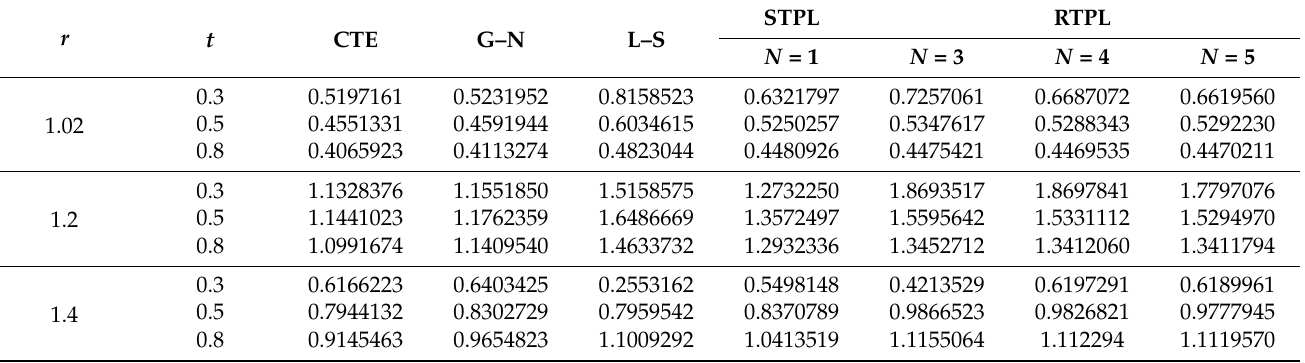
Table 3. Different thermoelasticity theories with a range of r values show the effects of dimensionless time t on temperature Θ .